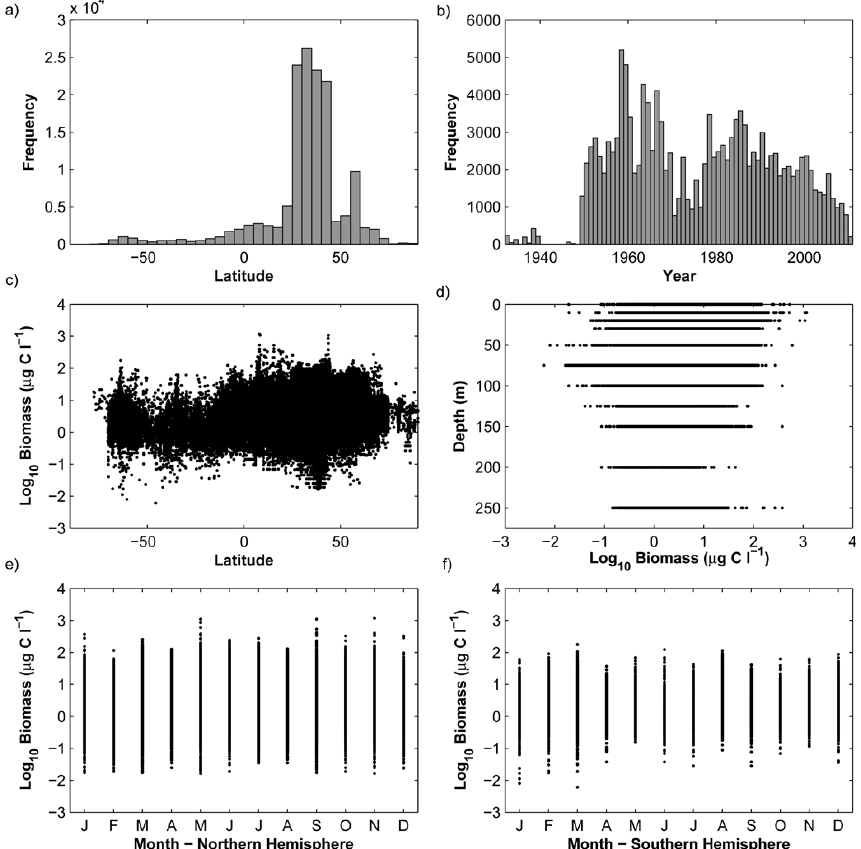
Figure 5. Description of mesozooplankton biomass observations: (a) latitudinal distribution, (b) yearly distribution, (c) latitudinal depth distribution, (d) depth distribution, (e) monthly distribution in the Northern and (f) Southern